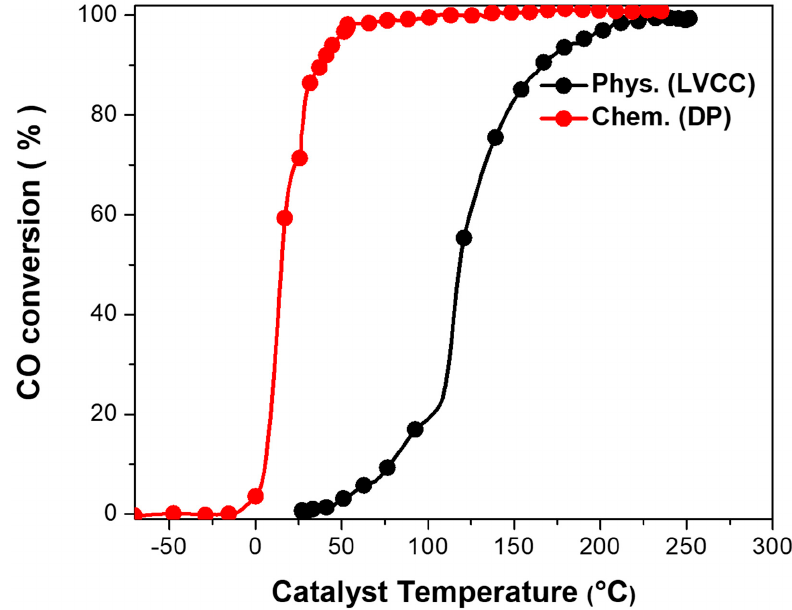
Figure 7. Comparison between activities of fresh Au/CeO 2 (first light-off) by a physical method (LVCC) and chemical method (DP). Sample mass = 10 mg, flow rate = 100 cc/min.